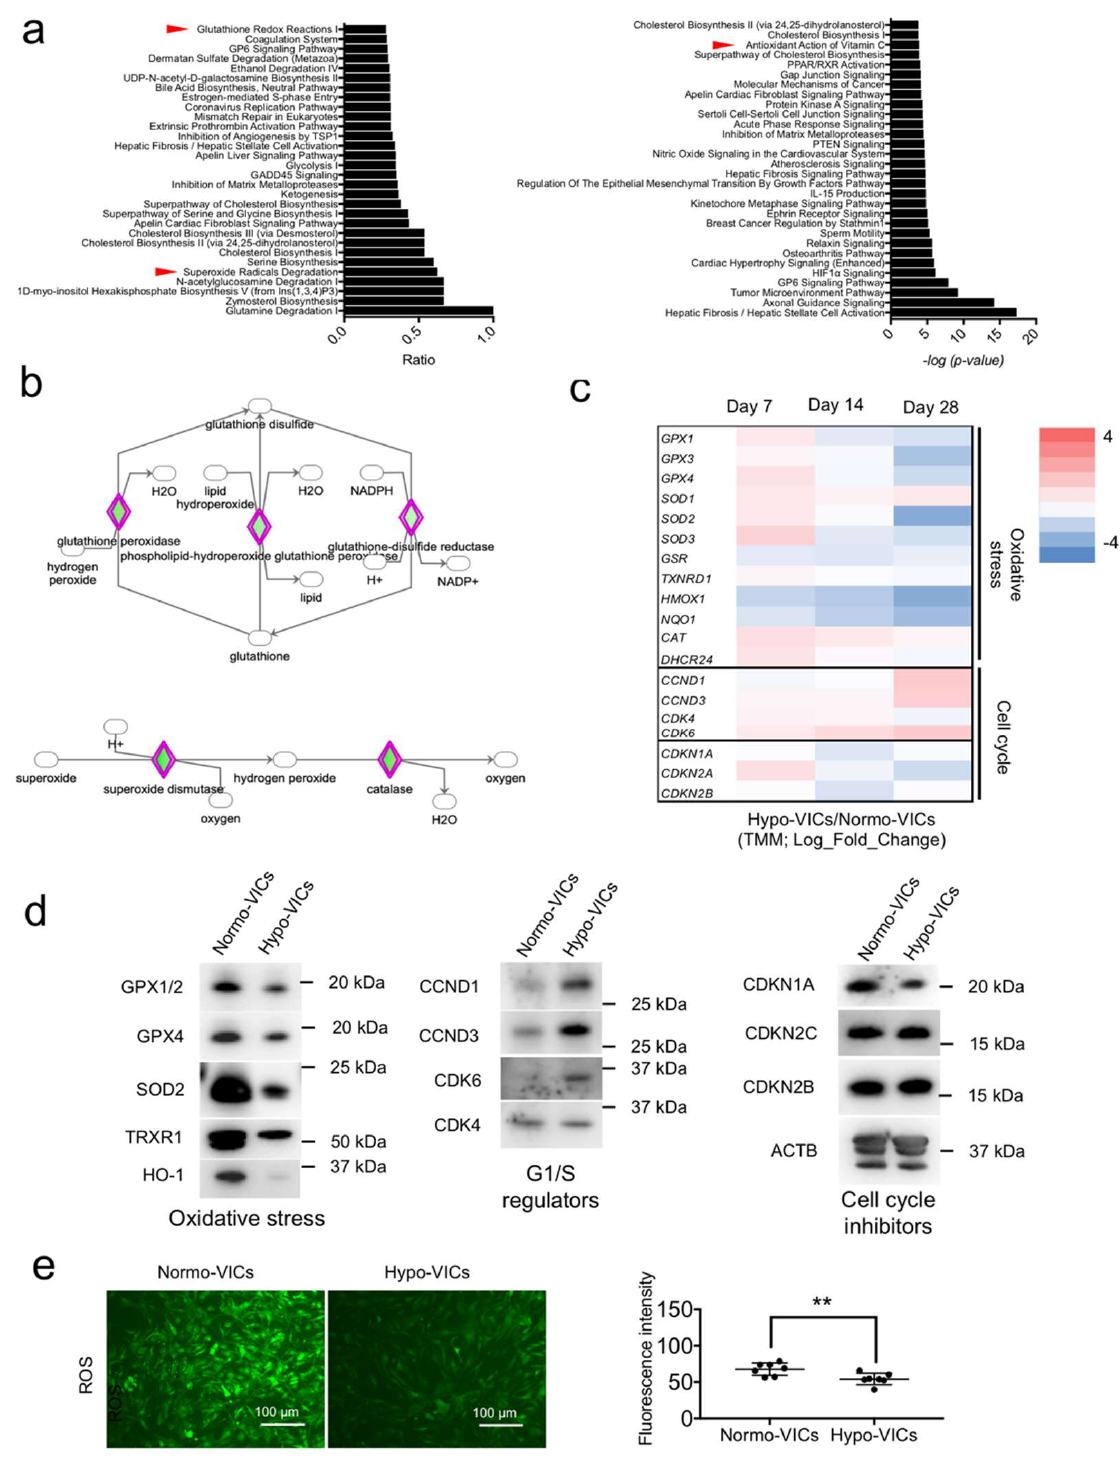
Figure 3. Expression of oxidative stress and cell-cycle regulators in normo- and hypo-VICs. ( a ) Top 30 candidates from canonical pathways (ratio and significance) from IPA analysis. Red arrowheads indicate canonical pathways pertaining to redox. ( b ) IPA pathway maps for glutathione redox reactions I and superoxide radical degradation. The rhombus colored in green denotes genes downregulated in hypo-VICs relative to normo-VICs. ( c ) Heatmap of expression of oxidative stress- and cell cycle-related genes from RNA-sequencing data (TMM). ( d ) Western blot detection of markers for oxidative stress and cell-cycle regulation. ( e ) Fluorescence micrographs of ROS. Bar = 100 µ m (left panel). ROS quantification (right panel). ** p < 0.01.